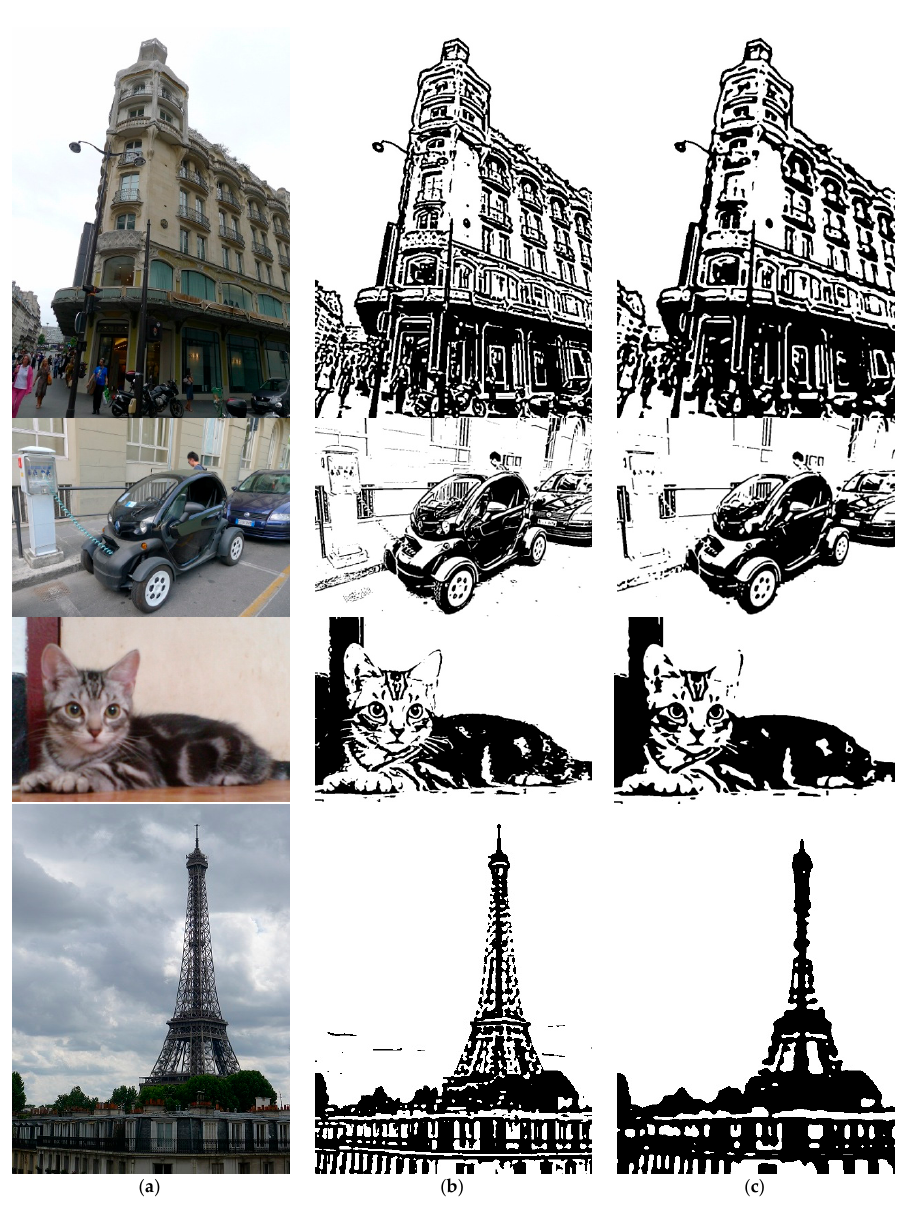
Figure 11. Some results of applying optional smoothing process. ( a ) input ( b ) binarization ( c ) optional smoothing